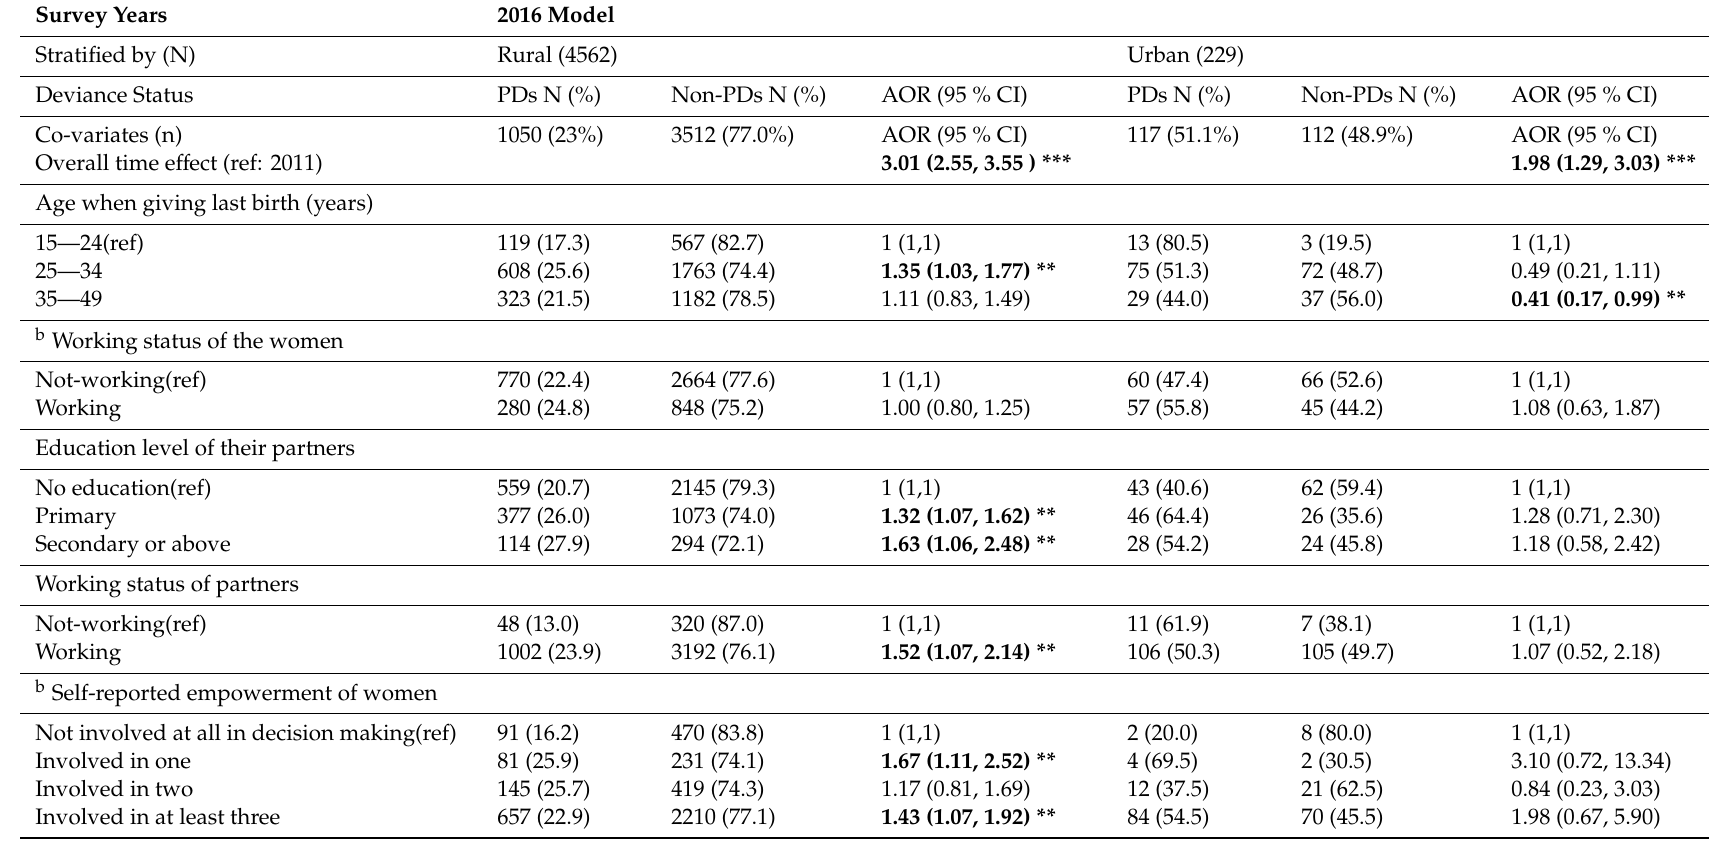
Table 3. Results of multiple multilevel logistic regression exploring factors associated with being a positive deviant for antenatal care utilization among urban and rural women, 2016 Ethiopia